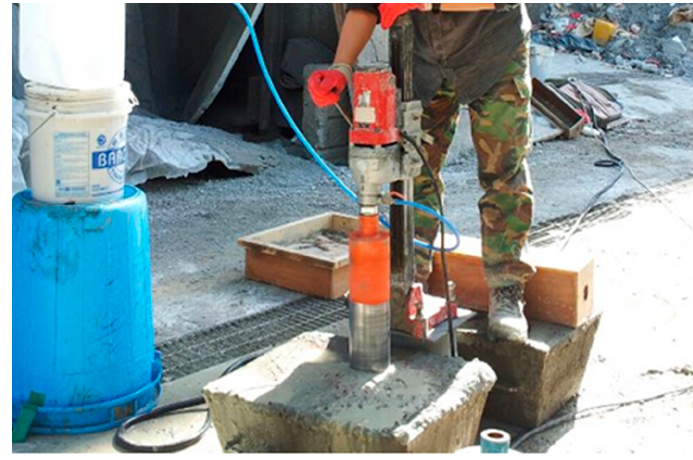
Figure 2. Core cutting from test panel.